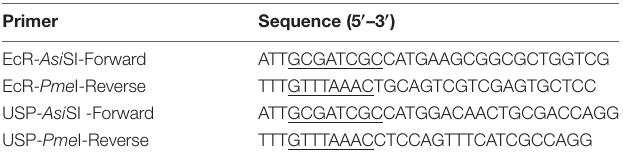
TABLE 1 | Primer sequences for NanoBiT cloning. Primer Sequence (5 (cid:48) –3 (cid:48)